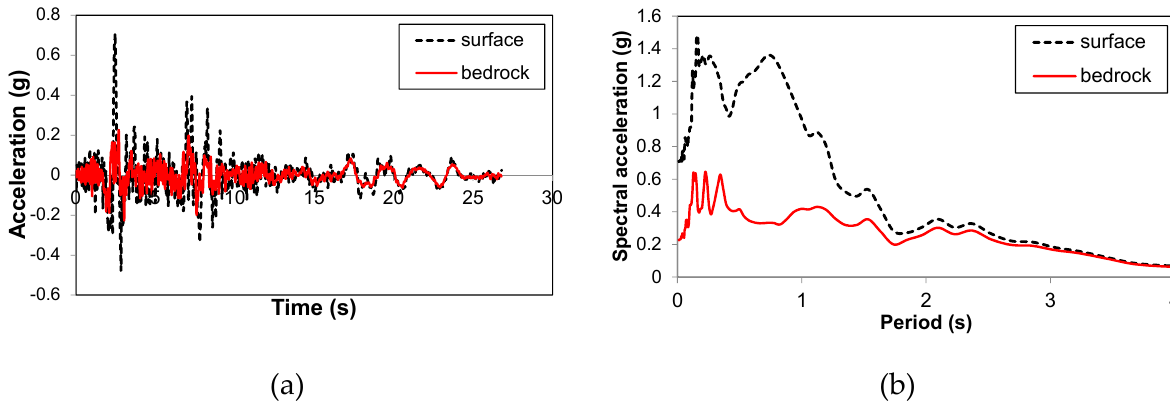
Figure 8. Comparison of the motion of the RSN1082-H2 record of Northridge earthquake on the surface and bedrock ( a ) acceleration record; ( b ) acceleration spectra.